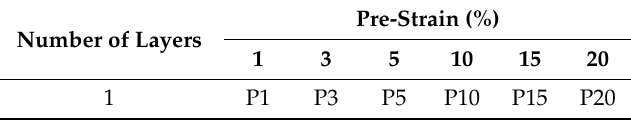
Table 2. Corrugated P3HT:PCBM photoactive thin film specimens are named based on the amount of applied